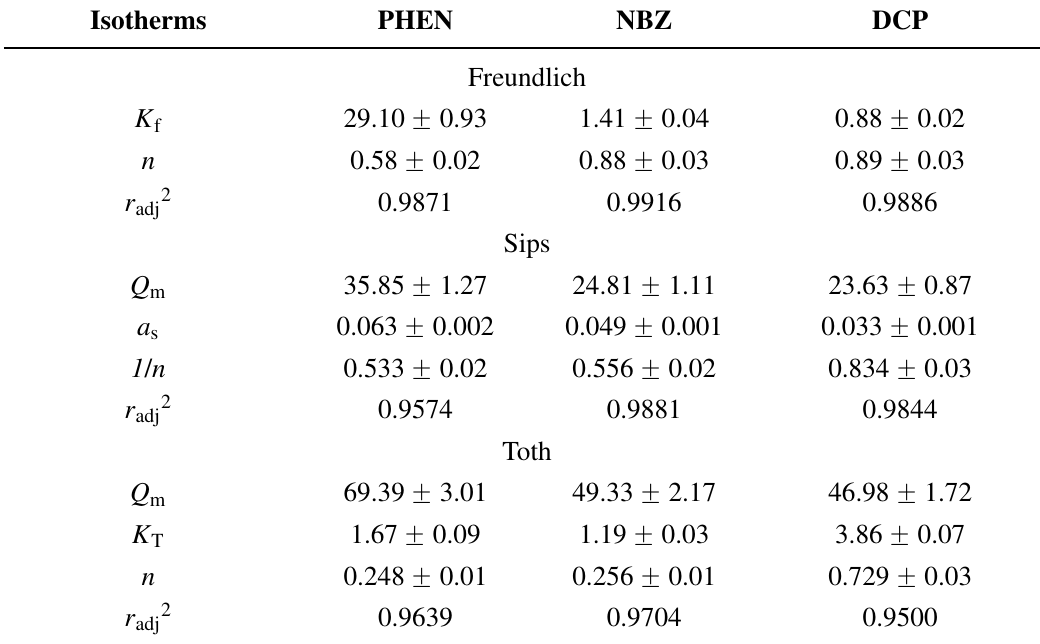
Table 1. Comparison of two-parameter and three-parameter isotherms for different organic pollutants. PHEN: phenanthrene; NBZ: nitrobenzene; DCP: 2,4-Dichlorophenol.